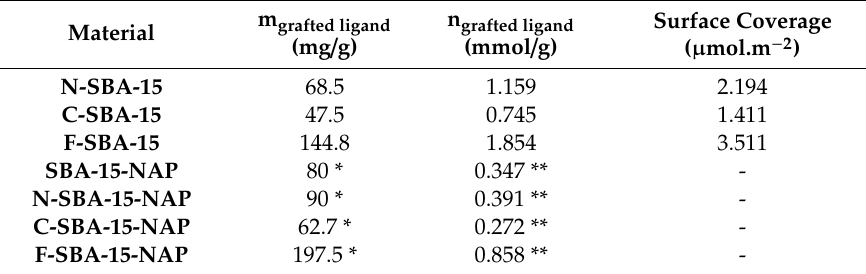
Table 3. Ligand and drug loading in the respective